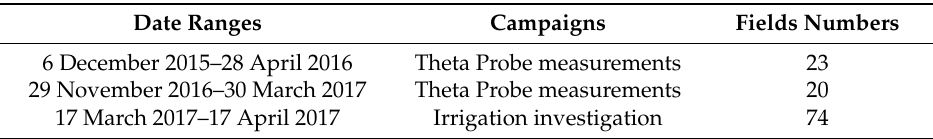
Table 1. Scheduling of the study site measurement campaigns between 2015 and 2017. Date